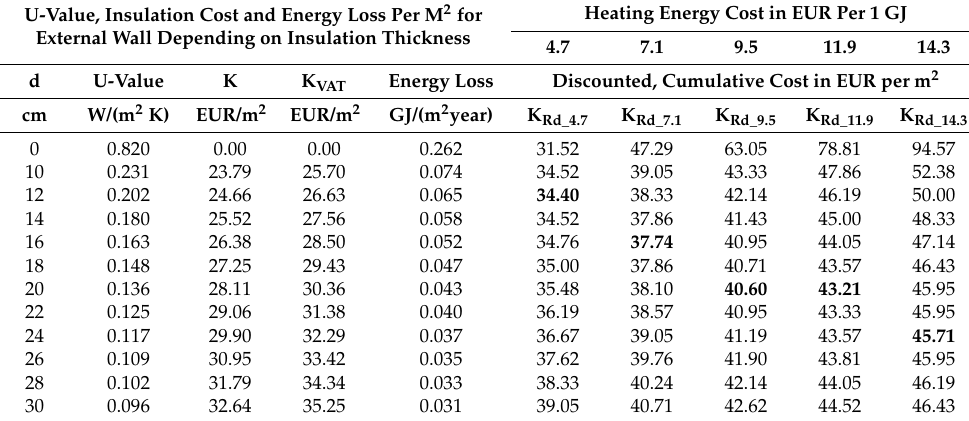
Table 11. The discounted, cumulative cost (K Rd ) per m 2 (the cost of energy loss plus the unit cost of renovation (K)) with tax (K VAT ), depending on the renovation option and the cost of energy. Insulation of external walls using EPS with λ = 0.033